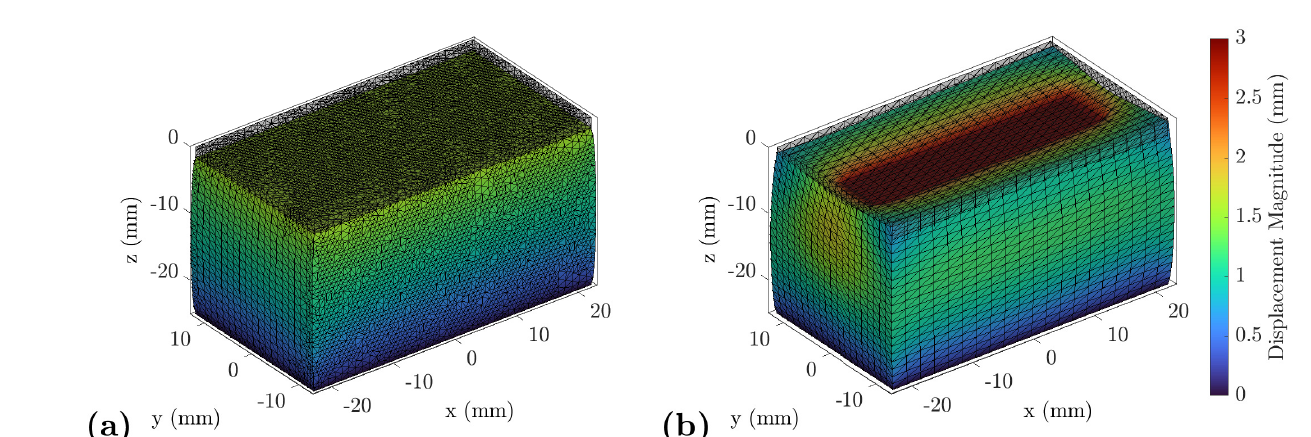
Figure 4. Exemplary result of the forward model: The dimensions of the simulated specimen are plotted on the x -, y - and z -axis, where the coordinate origin was chosen in the center of the compressing object. The color indicates the magnitude of the simulated displacement vector in relation to the initial position. ( a ) The compression of the complete upper surface—in this work, referred to as the compression test. ( b ) The spatially limited compression with the transducer, here called the indentation